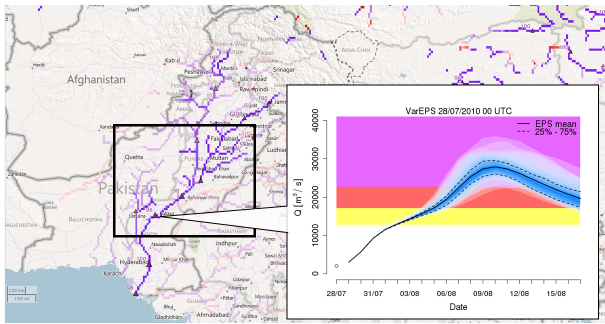
Fig. 10. 20-day ESP on 28 July 2010 for a dynamic reporting point in the Indus River near Sukkur, in Pakistan. The probability of severe threshold exceedance is shown with purple shadings. The black-contoured rectangle indicates the area shown in Fig.